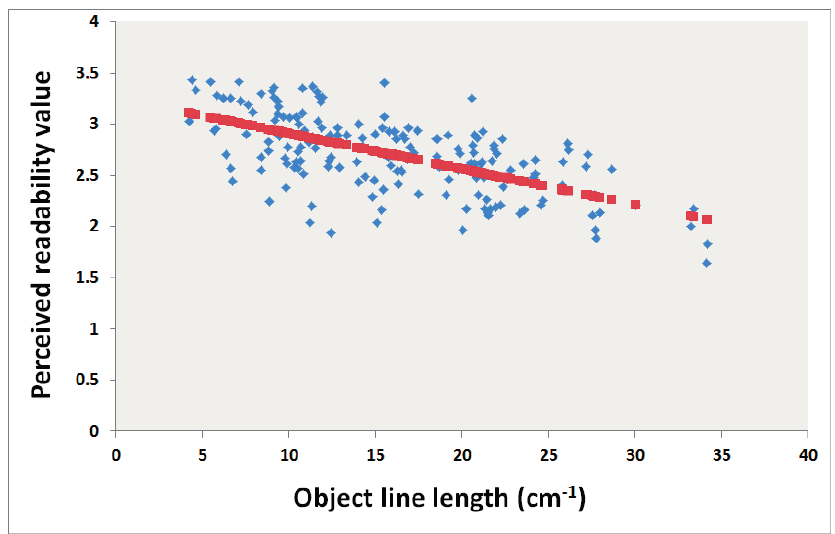
Figure 3. Relationship between the perceived readability value and the object line length.